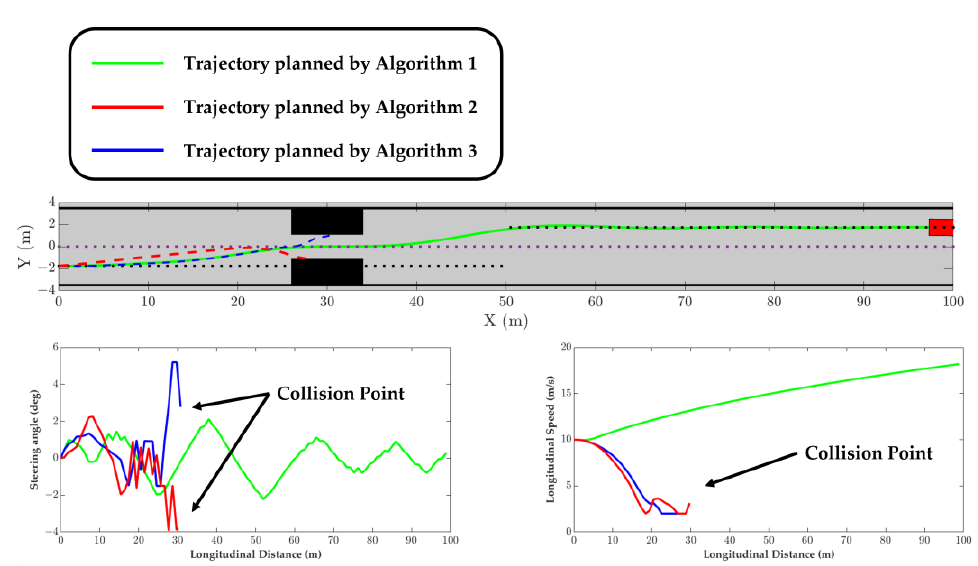
Figure 5. The results of Experiment 2.